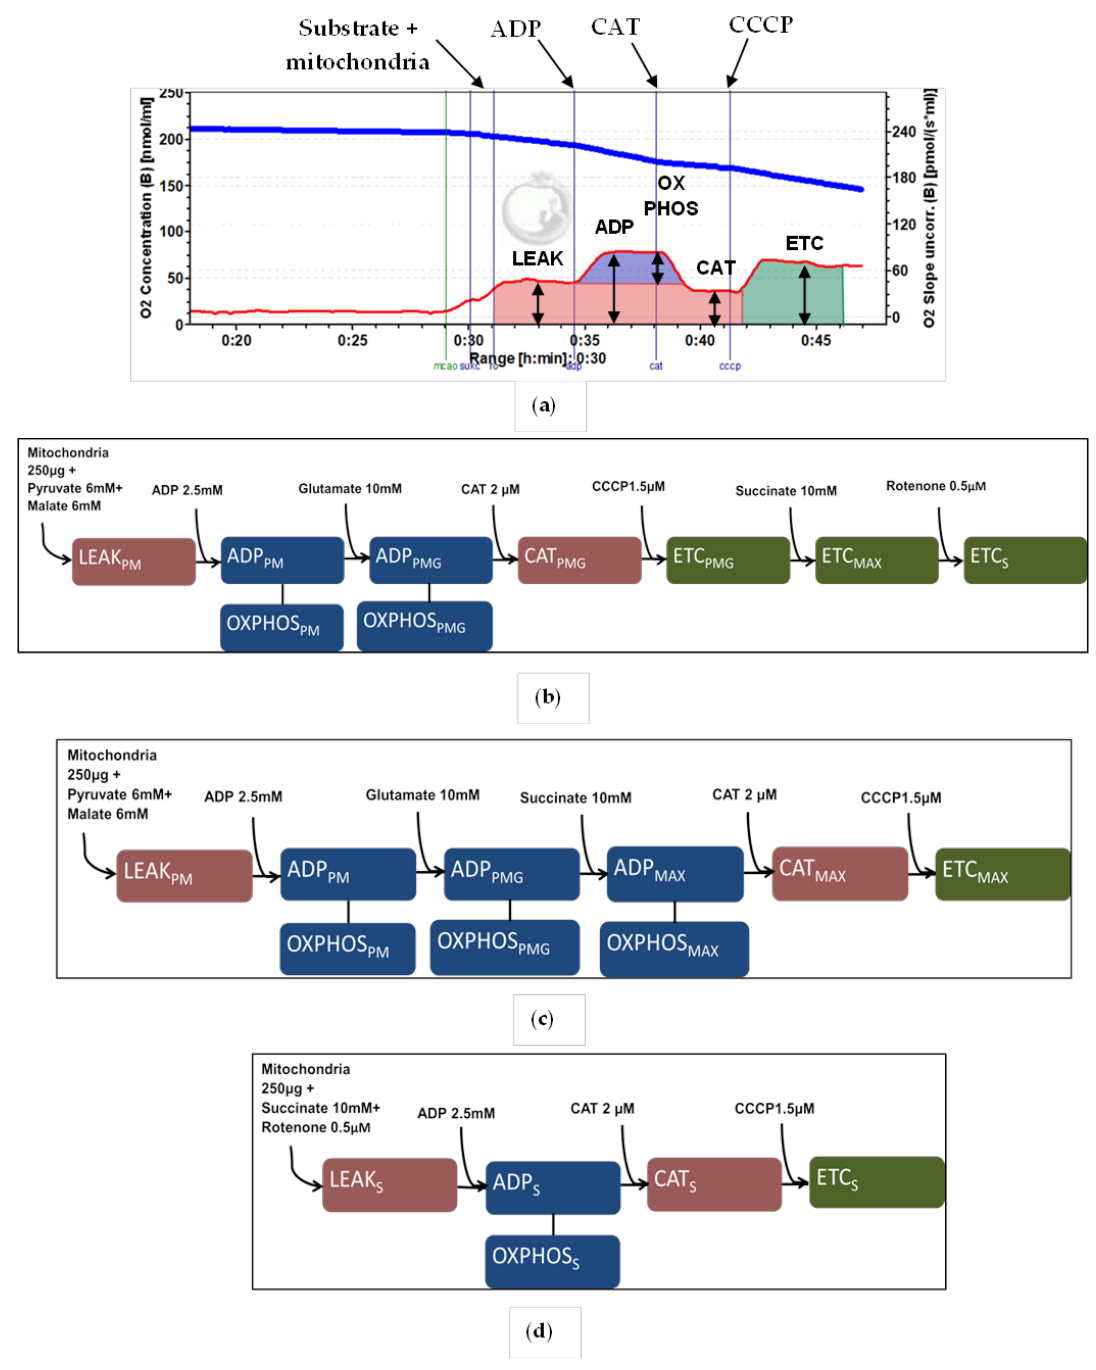
Figure 5. Substrate, uncoupler, and inhibitor titration protocols. ( a )—Representation of different metabolic states investigated in our experiments. Image is taken from Oroboros DatLab software interface, where the blue line represents oxygen concentration in the chamber and the red line represents the OCRs at a given moment. ( b )—Substrate, uncoupler, and inhibitor titration protocol 1. ( c )—Substrate, uncoupler, and inhibitor titration protocol 2. ( d )—Substrate, uncoupler, and inhibitor titration protocol